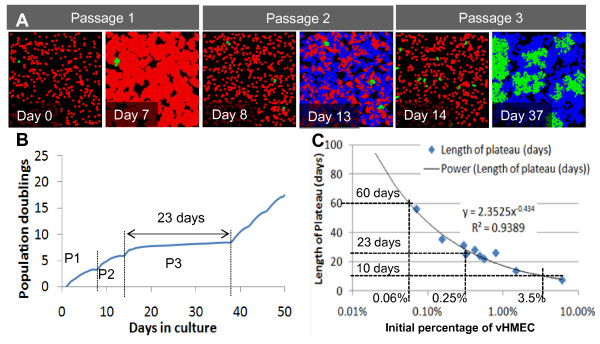
Growth and senescence of heterogeneous human mammary epithelial cells cultures can be accurately modeled using the agent-based model. (A and B) In a model extending over several passages, cells are initially plated at 20% confluence and replated when the populations reach 80% confluence. By Passage 3, most human mammary epithelial cells (HMEC) have undergone seven divisions, and enter stasis. As a result, the time to confluence is extended, and a population doubling plateau is observed. Ultimately, the variant human mammary epithelial cells (vHMEC) take up the available area, and exponential growth resumes. (C) Changing the initial density of vHMEC leads to variable plateau periods. This dependence is fitted by a power function that allows the calculation of the initial density of vHMEC present in the primary culture based on plateau length. The results of individual simulations are plotted as points.